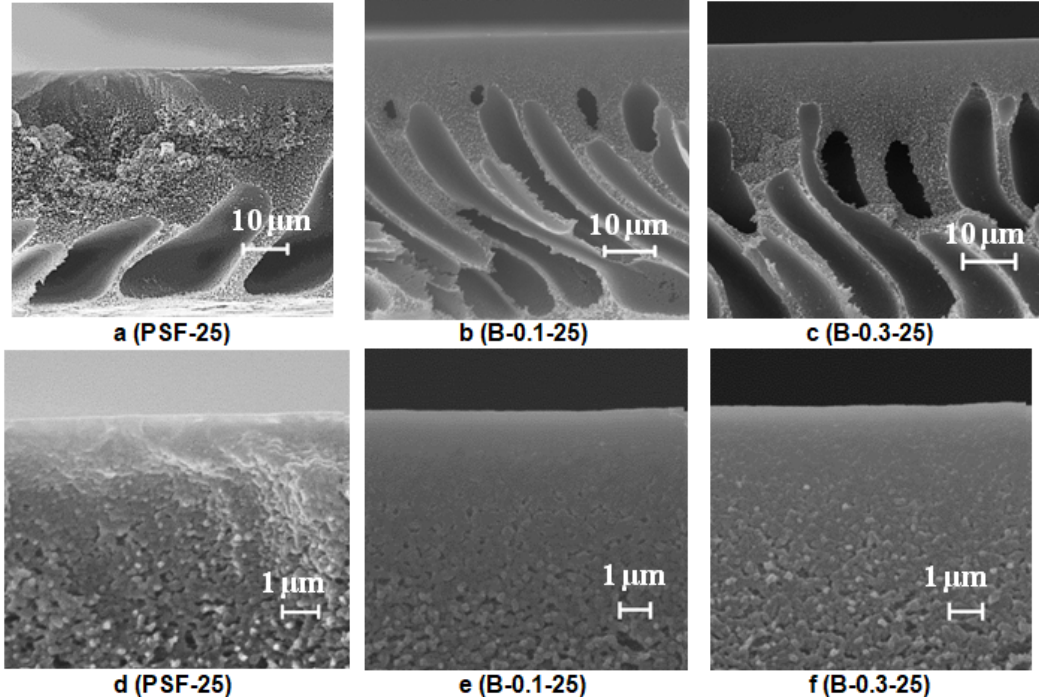
Figure 7. SEM images of the PSF membrane cross-section ( a – c ) and selective layer ( d – f ) prepared using a rough glass plate, Praestol 859 concentration in the coagulation bath ( T = 25 ◦ C), wt.%: ( a , d ) 0; ( b , e ) 0.1; ( c , f ) 0.3.